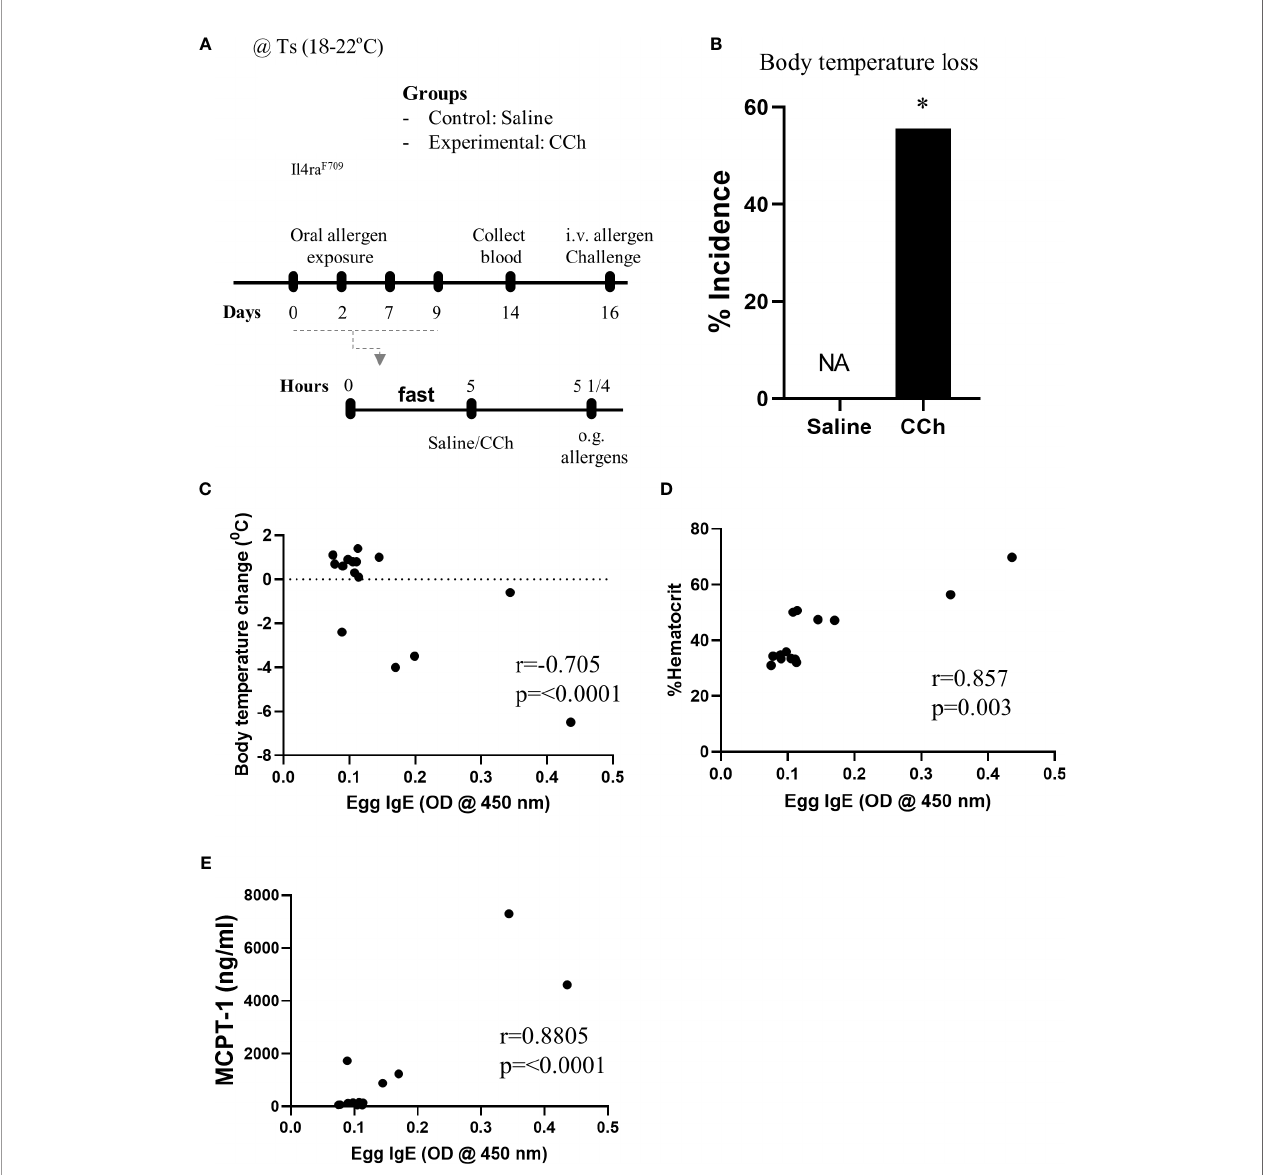
FIGURE 2 | Antigen passage activation predisposes Il4ra F709 mice to food sensitization at the standard temperature. (A) Experimental scheme of the adjuvant free oral sensitization with Il4ra F709 mice. (B) % incidence of clinical reactivity following the systemic allergen challenge on day 16. NA indicates 0 value. Fisher ’ s exact test was used for the statistical analysis of the odds ratio. (C-E) Correlation analysis for egg IgE and (C) body temperature change, (D) % hemoconcentration, and (E) MCPT-1 following the systemic allergen challenge on day 16. r indicates the Pearson correlation coef fi cient. CCh, carbachol; i.v., intravenous; o.g., oral gavage; Ts, standard housing temperature. n=6-8 per group. * denotes statistical signi fi